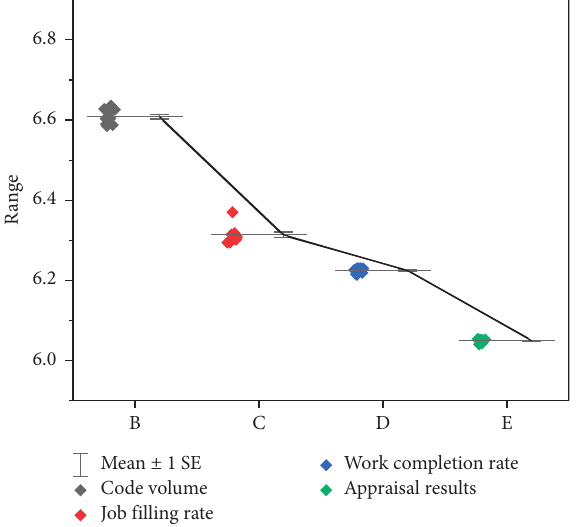
Figure 4: Performance appraisal